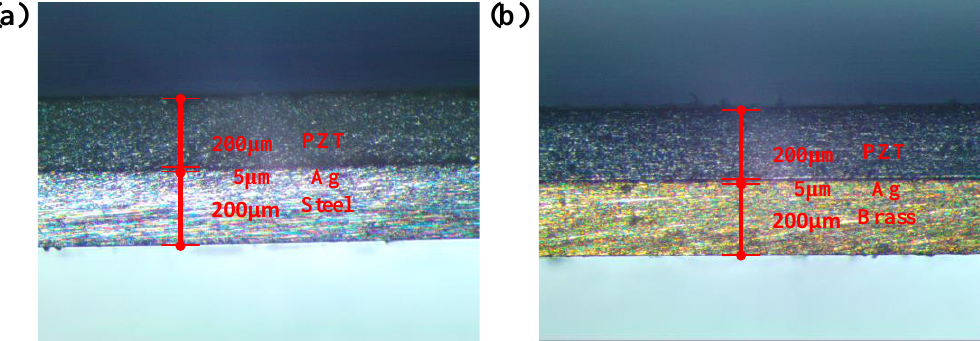
Figure 4. The cross-section (OM) of PEH. ( a ) Stainless steel substrate PEH. ( b ) Brass substrate PEH.